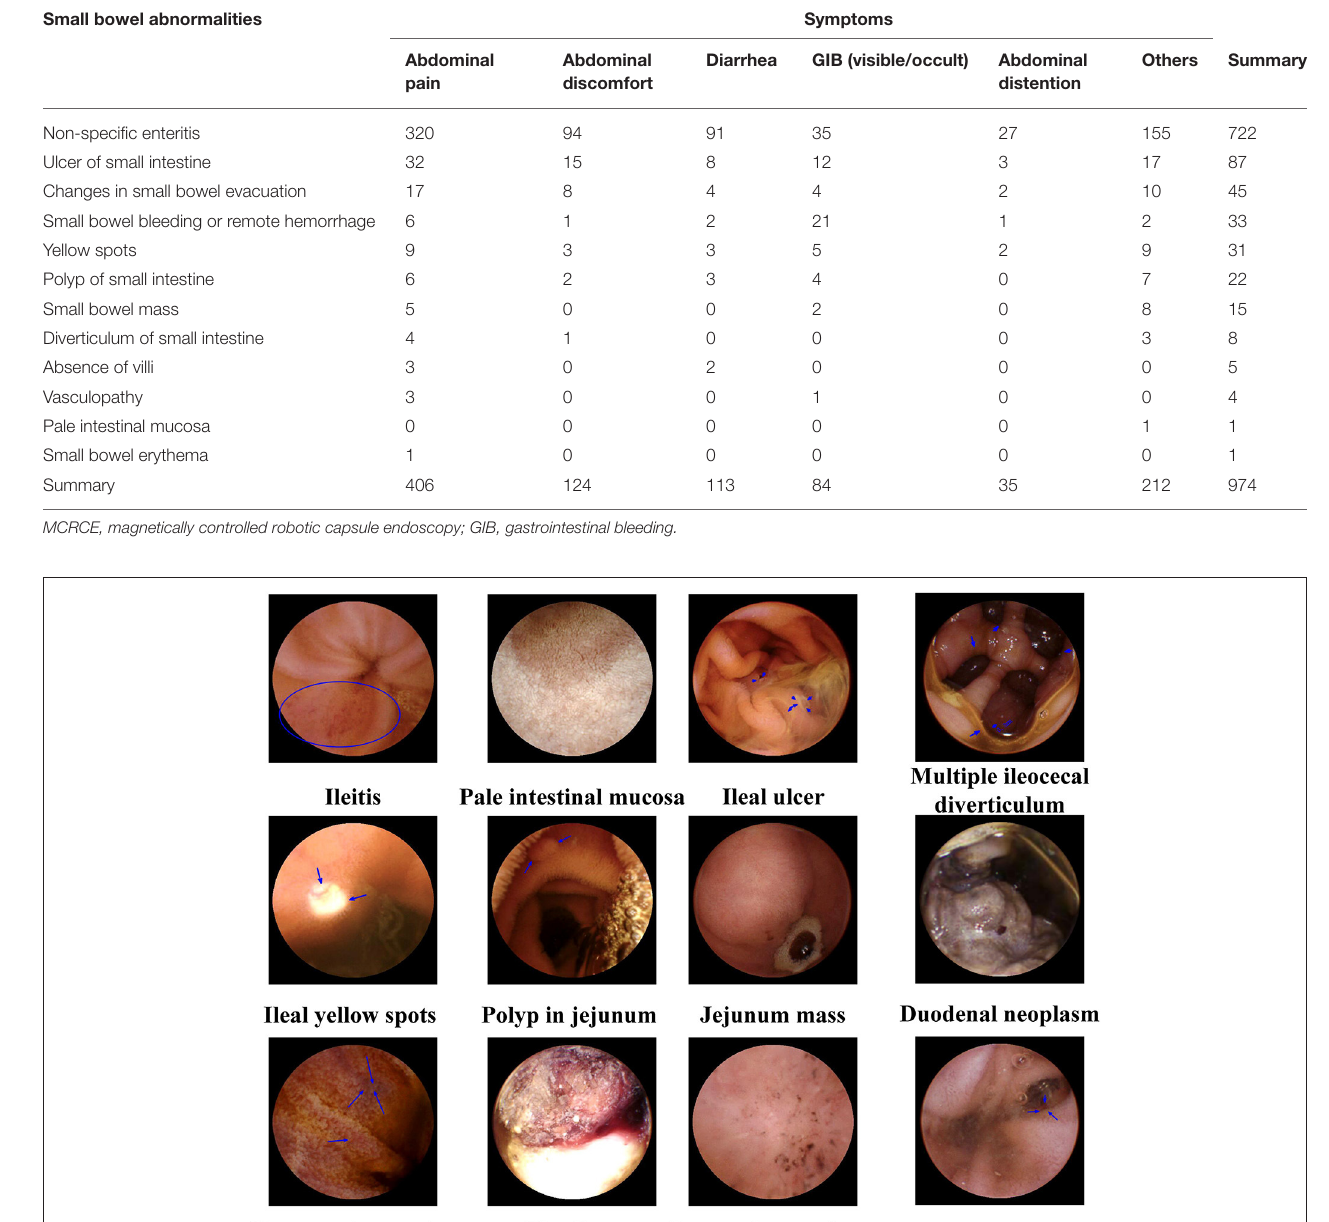
TABLE 2 | Types of intestinal diseases detected by MCRCE.